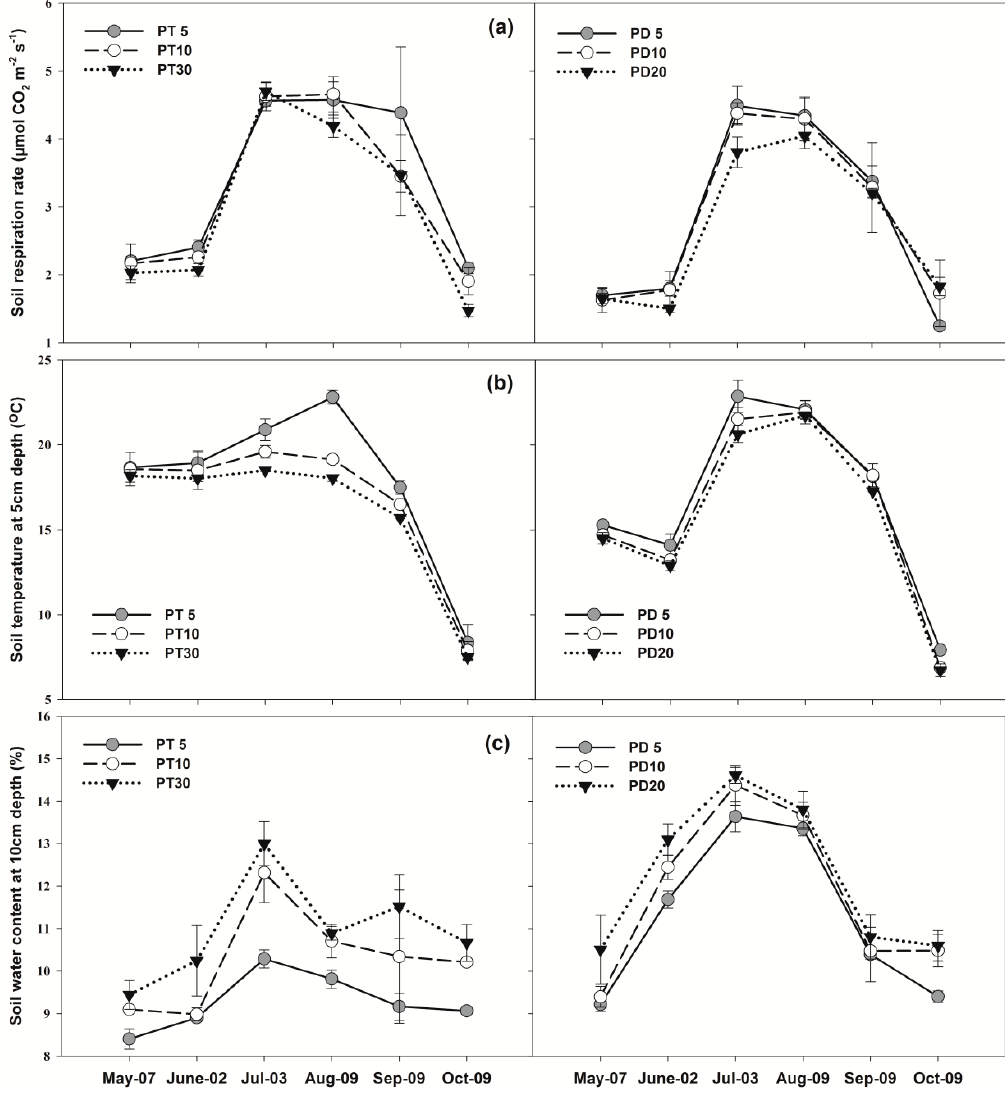
Figure 3. Monthly variations in the soil respiration rate ( a ); soil temperature at 5 cm depth ( b ); and soil water content at 10 cm ( c ) among different stand ages in Pinus tabulaeformis and Populus davidiana plantations during the growing season (from May to October) of 2013. PT and PD represent P. tabulaeformis and P. davidiana plantations respectively, and the digits represent stand ages. Bars indicate standard errors.